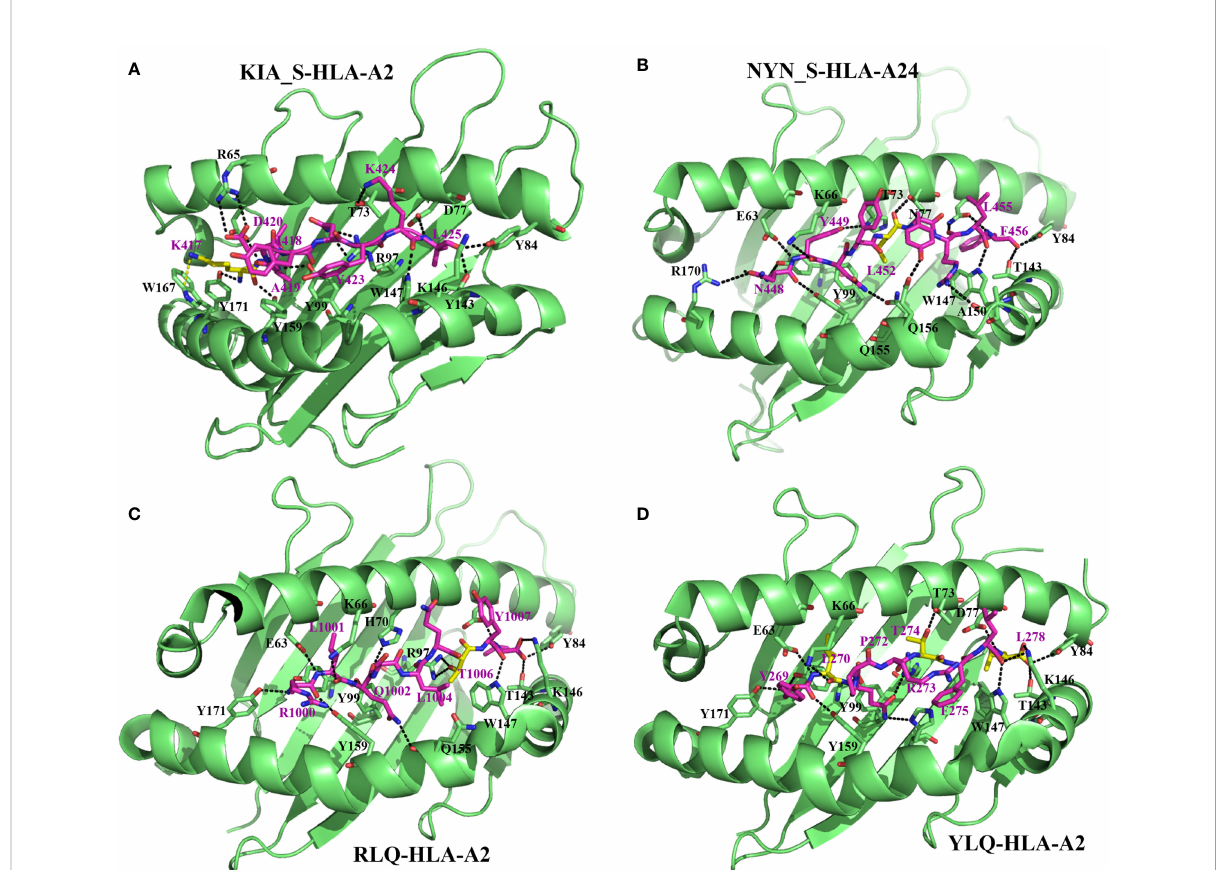
FIGURE 2 Molecular bases of epitope – HLA-I complexes and effects of epitope mutations. Interactions between KIA_S peptide and HLA-A*02:01 (from PDB:7EU2) (A) , NYN_S peptide and HLA-A*24:02 (7F4W) (B) , RLQ peptide and HLA-A*02:01 (7N1B) (C) , and YLQ peptide and HLA-A*02:01 (7N1A) (D) . For all the structures, HLA heavy chains are green, the SARS-CoV-2 peptides are purple, and residues with predominant mutational rates with an effect on immune escape are shown in yellow. Residues at the interface of the interaction of HLA with peptides are represented: nitrogen atoms in blue, oxygen atoms in red, and hydrogen bonds are indicated by black dashed